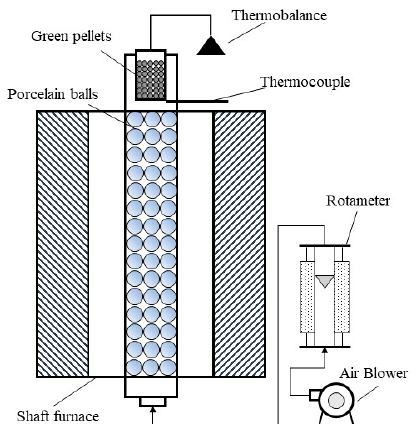
Figure 1. Schematic figure of the self-equipped device for drying